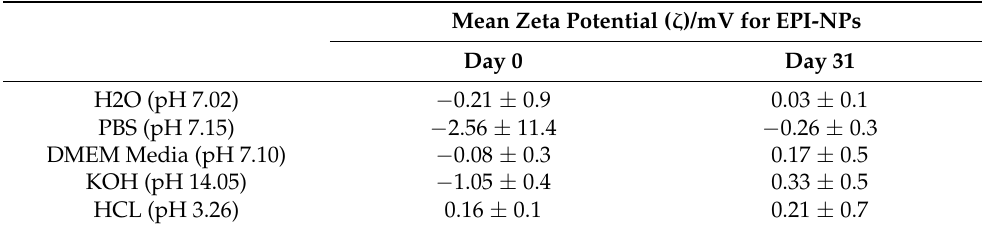
Table 2. Mean zeta potential at day 0 and day 31 for epirubicin-loaded NPs. The data represent the mean average of the five instrument runs for each sample ± SD.